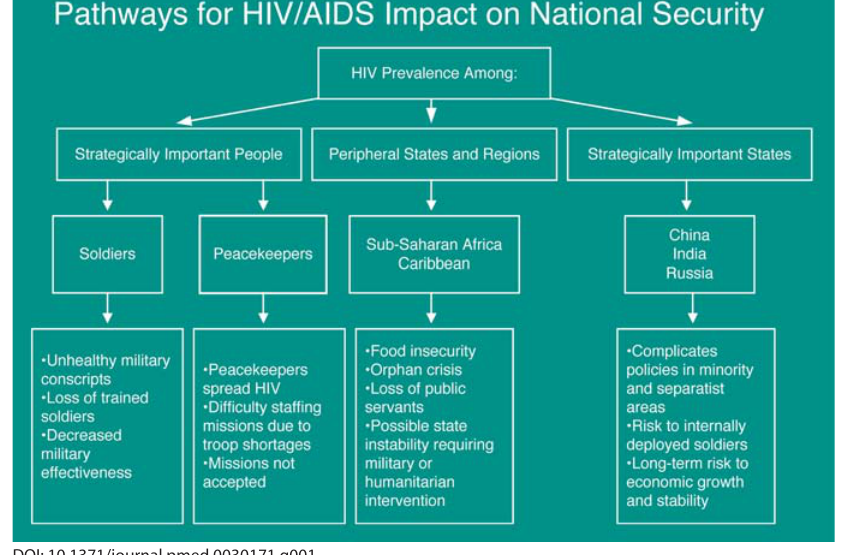
Figure 1. Pathways through Which HIV/AIDS Has an Impact upon National